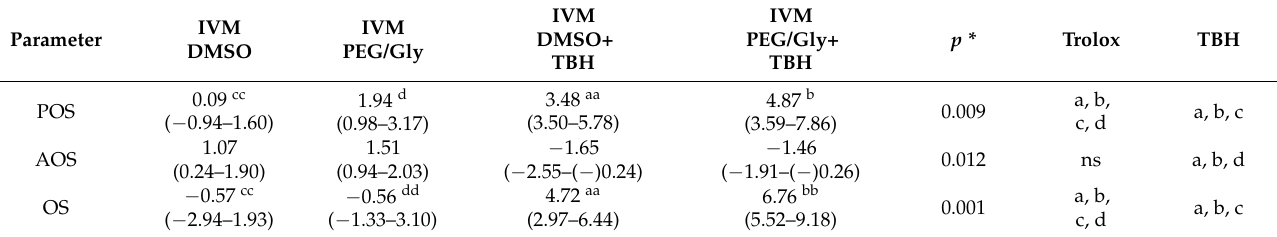
Table 3. POS, AOS and OS of IVM after 24